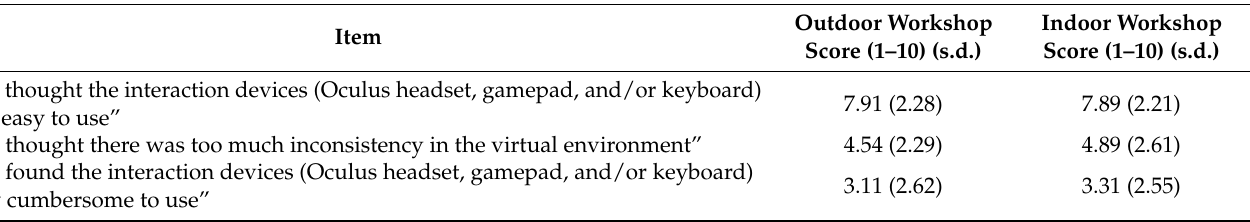
Table 7. Questionnaire on User experience in Immersive Virtual Environments: usability subscale. Questionnaire on User Experience in Immersive Virtual Environments: Usability